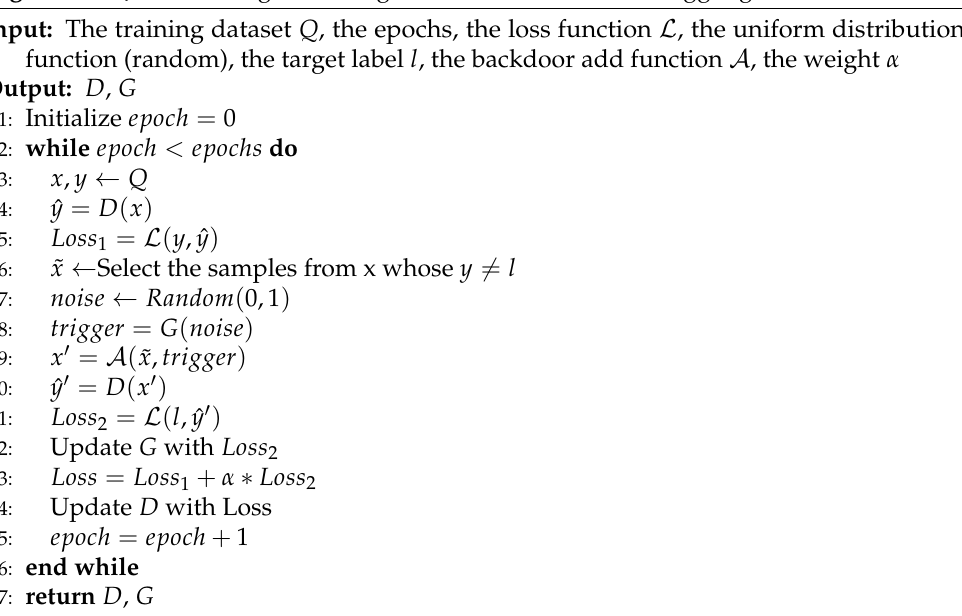
Algorithm 1 Joint training of the target victim model and the trigger generation